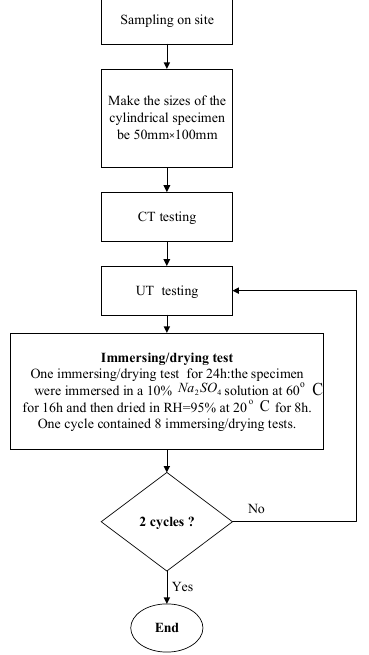
Figure 1. Experimental steps.